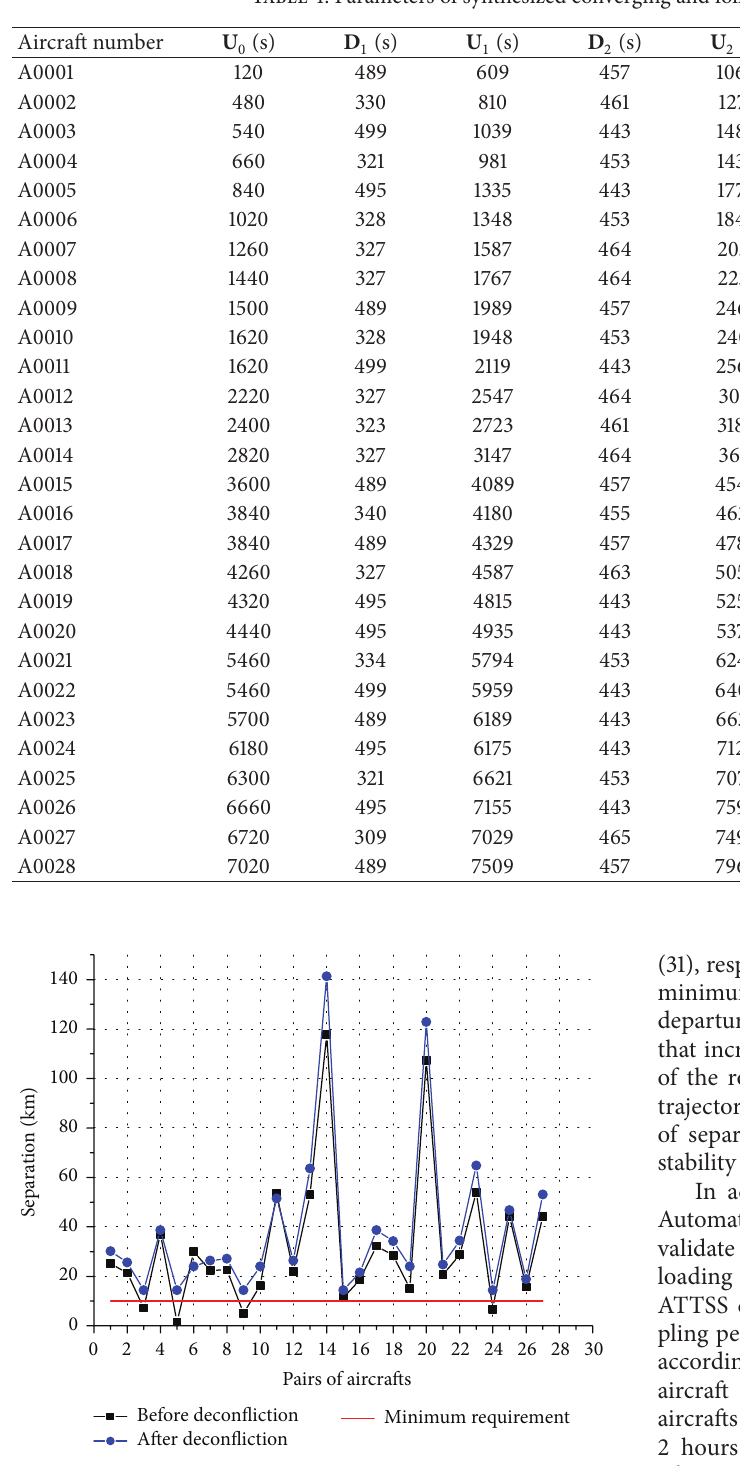
Figure 17: Separation between two adjacent aircrafts arriving at